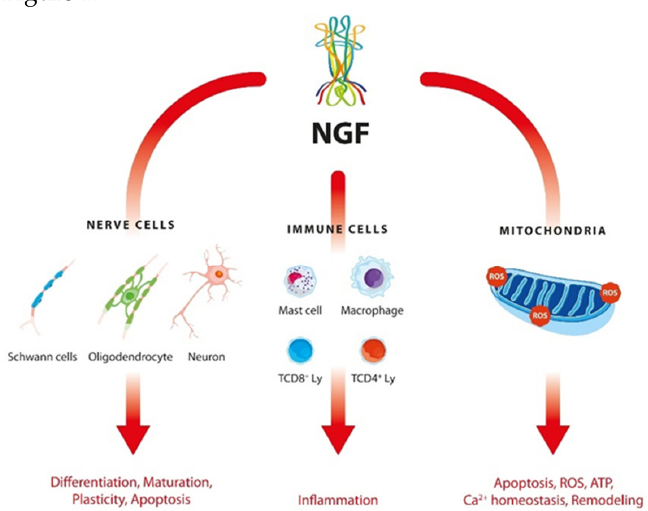
Figure 1. Interactions of NGF with nerve and immune cells in ASD.